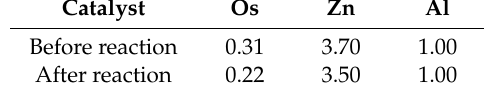
Figure 5. XRD of Os – HTlc used in the aminohydroxylation reaction at 25 °C and chloramine-T as nitrogen source. Table 4. The metal ratio in the catalyst before and after the reaction, as determined by ICP-OES analysis.